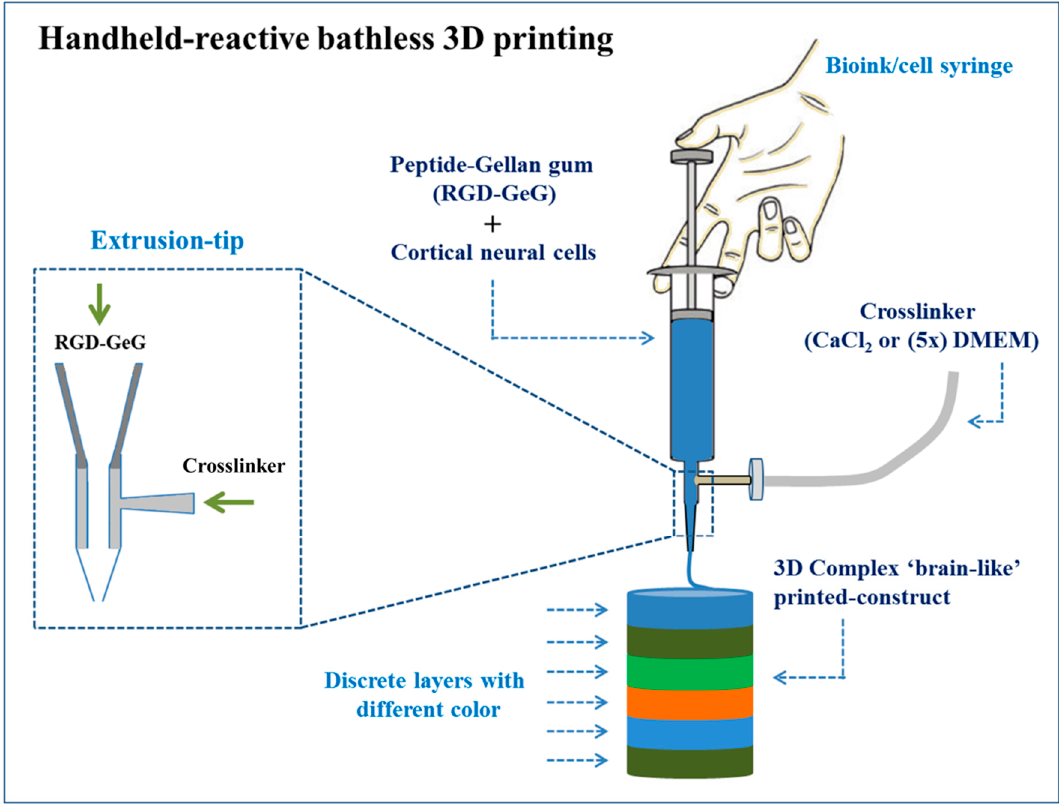
Figure 6. Handheld reactive bathless 3D printing: Schematic diagram of extrusion-tip and 3D printed ‘brain-like’ layered-construct composed of peptide (RGD), gellan gum (GeG), and cortical neural cells (i.e., each color denoted by a layer) [211].